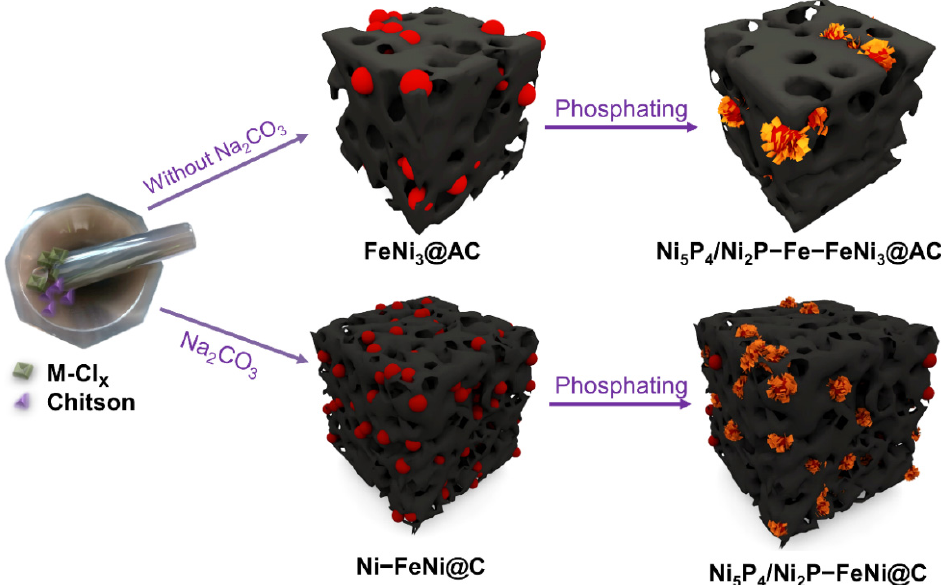
Figure 1. Schematic illustration of the synthesis process for Ni 5 P 4 /Ni 2 P–Fe–FeNi 3 @AC catalysts and Ni 5 P 4 /Ni 2 P–FeNi@C.